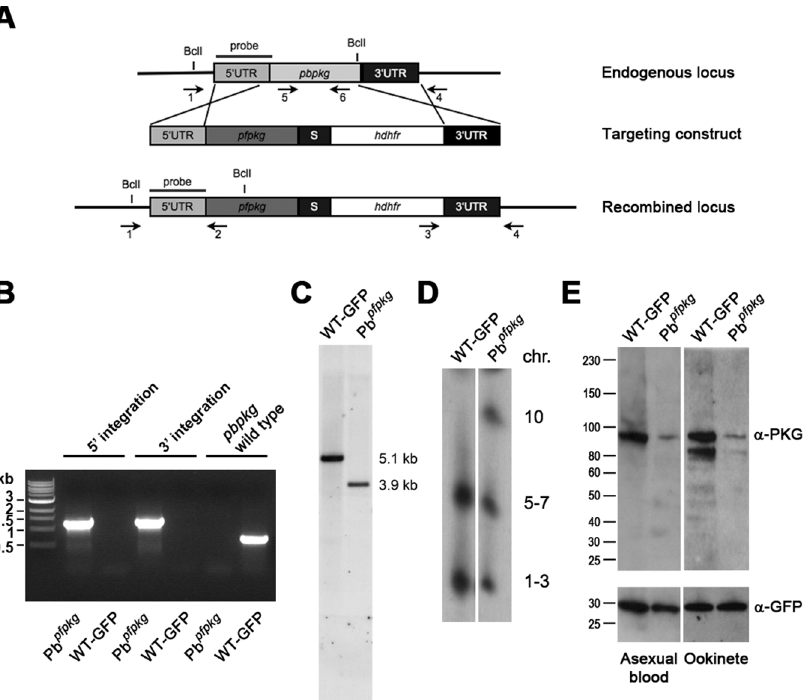
Figure 1. Generation of Pb pfpkg parasites. A) Schematic diagram of the endogenous pbpkg locus, the targeting construct and the transgenic pb pfpkg locus. Areas of 5 9 UTR and 3 9 UTR cloned into the targeting vector are indicated, S=spacer. Arrows 1–6 indicate binding sites for primers used in diagnostic PCR. Primers 1 and 2 were used to detect 5 9 integration. Primers 3 and 4 were used to determine 3 9 integration. Primers 5 and 6 bind specifically to the endogenous pbpkg and are used to confirm absence of the endogenous gene in the transgenic line. The area homologous to the probe used in Southern blotting and Bcl I restriction sites used for diagnostic digest are indicated. B) Diagnostic PCR used to determine integration of the targeting construct into the Pb pfpkg transgenic line. C) Southern blot following Bcl I digest shows integration of the targeting construct as a specific 3.9 kb band and absence of the endogenous 5.1 kb band in the transgenic line (Pb pfpkg ) in comparison to wild type (WT-GFP). D) PFGE of wild type (WT-GFP) and mutant parasite (Pb pfpkg ) confirms integration into the correct chromosome. E) Western blot of asexual blood and ookinete stages confirm expression of PfPKG in the transgenic line (the transgenic PfPKG bands are 25.8% and 21.8% of the PbPKG band in the WT-GFP line in asexual blood and ookinete stages respectively).